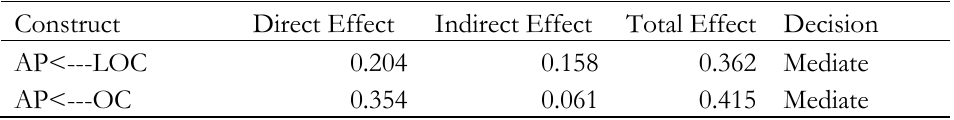
Table 5. Direct and indirect